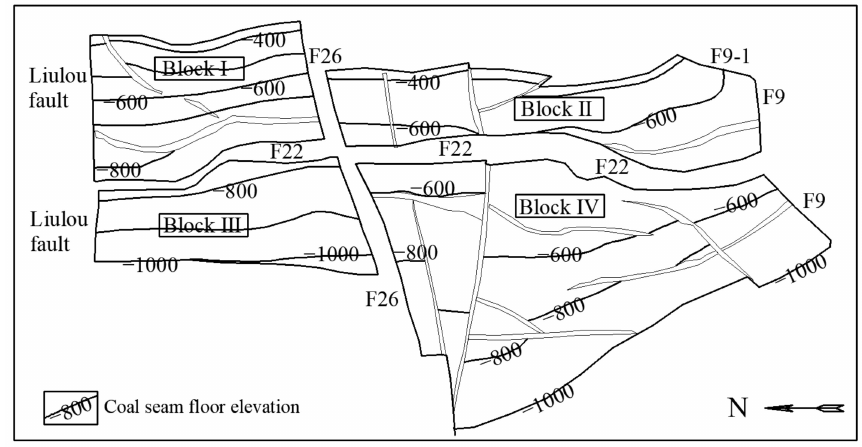
Figure 8. Tectonic map of no. 8 coal seam at the Guobei coal mine. Modified from